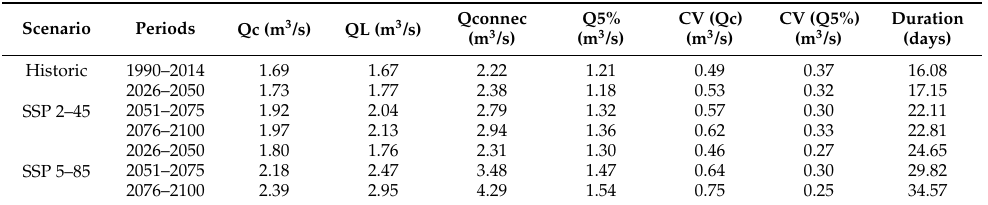
Table 7. Ensemble of the hydrological parameters related to floods of each GCMS (data obtained from IAHRIS).